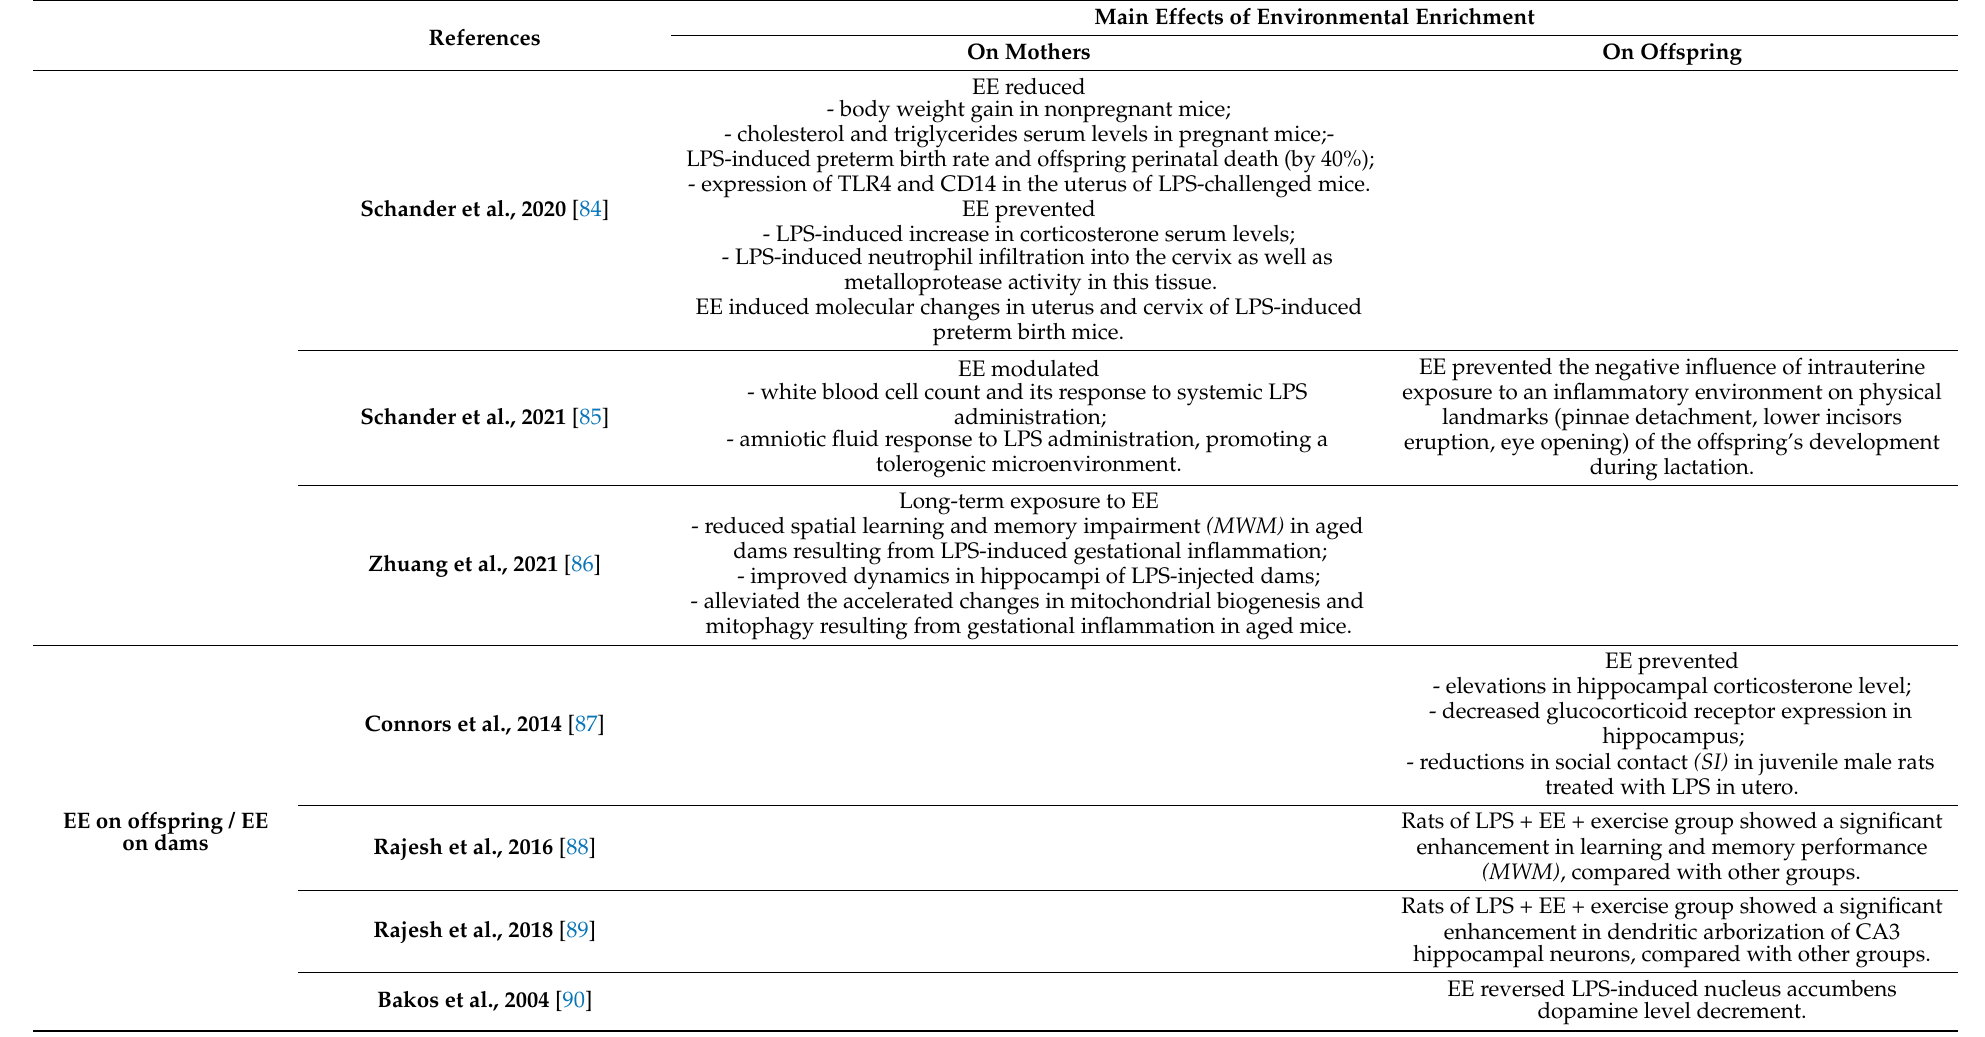
Table 2. Main effects of environmental enrichment in case of prenatal